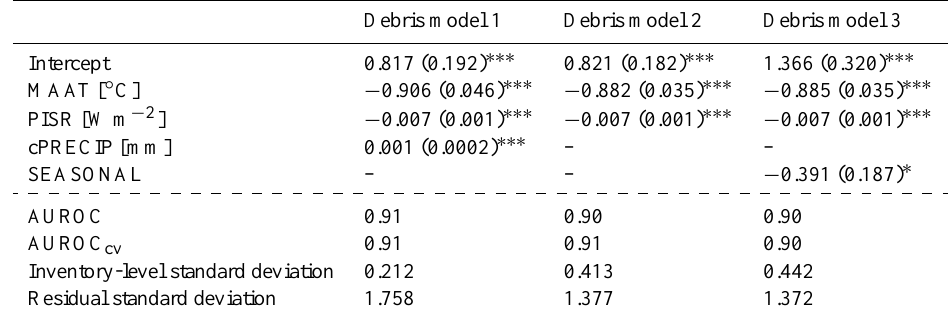
Table 3. Model coefficients (and standard errors in parentheses) of debris models using different sets of explanatory variables, and the corresponding goodness-of-fit statistics. Debris model 1 was chosen as final model. (The units for the explanatory variables are given in square brackets for each coefficient.)